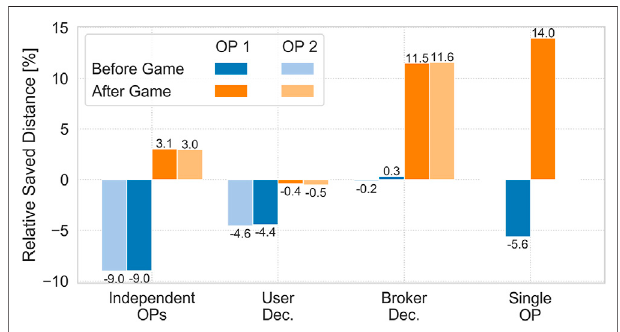
FIGURE 10 | Saved Distance before and after the game for the different interaction scenarios.